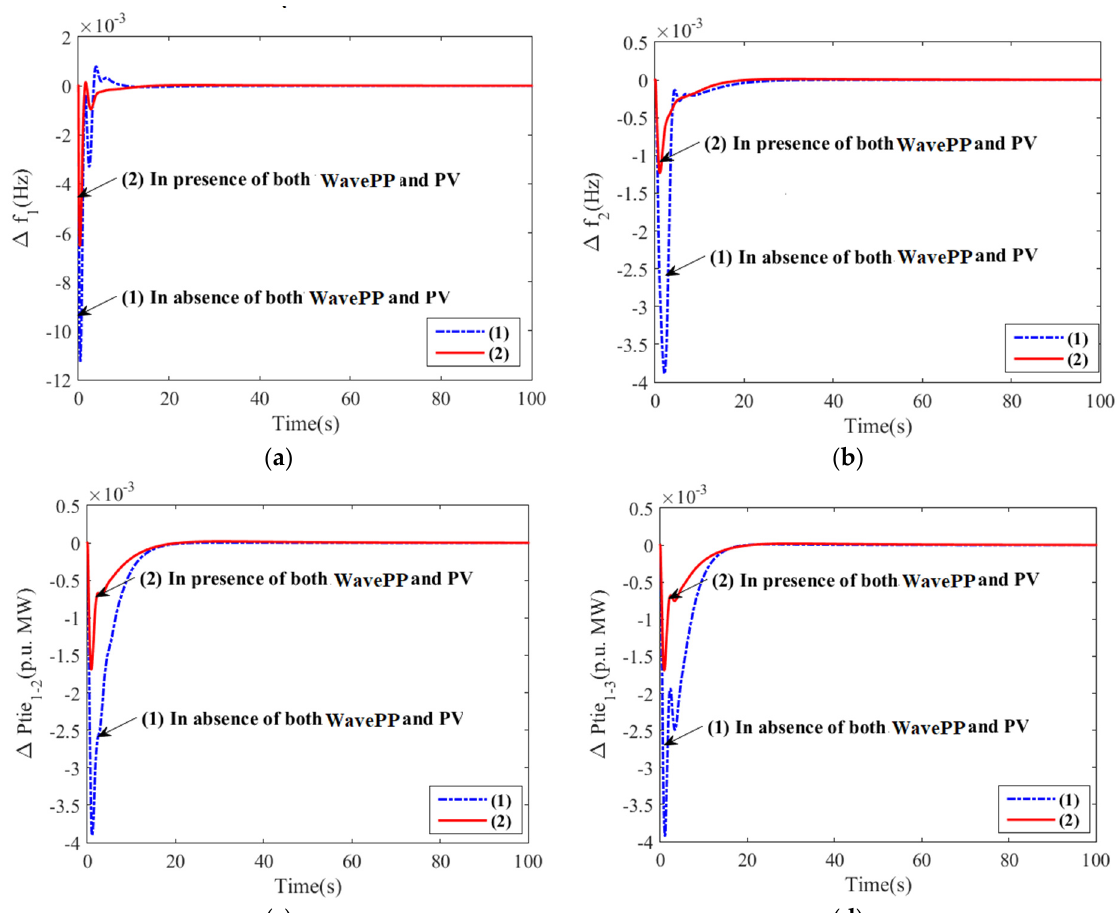
Figure 10. Assessment of the impact of both WavePPt for system-4 contrast time: ( a ) Anomaly of frequency in area-1, ( b ) Anomaly of frequency in area-2 vs. time, ( c ) Anomaly of Tie-line power interlinking area-1 and area-2, ( d ) Anomaly of Tie-line power interlinking area-1 and area-3.